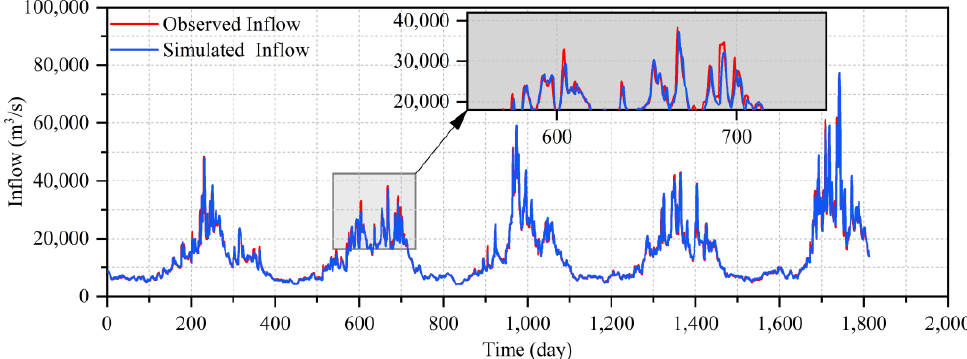
Figure 7. Simulated inflow hydrograph of the TGR by the GRU during the testing period.